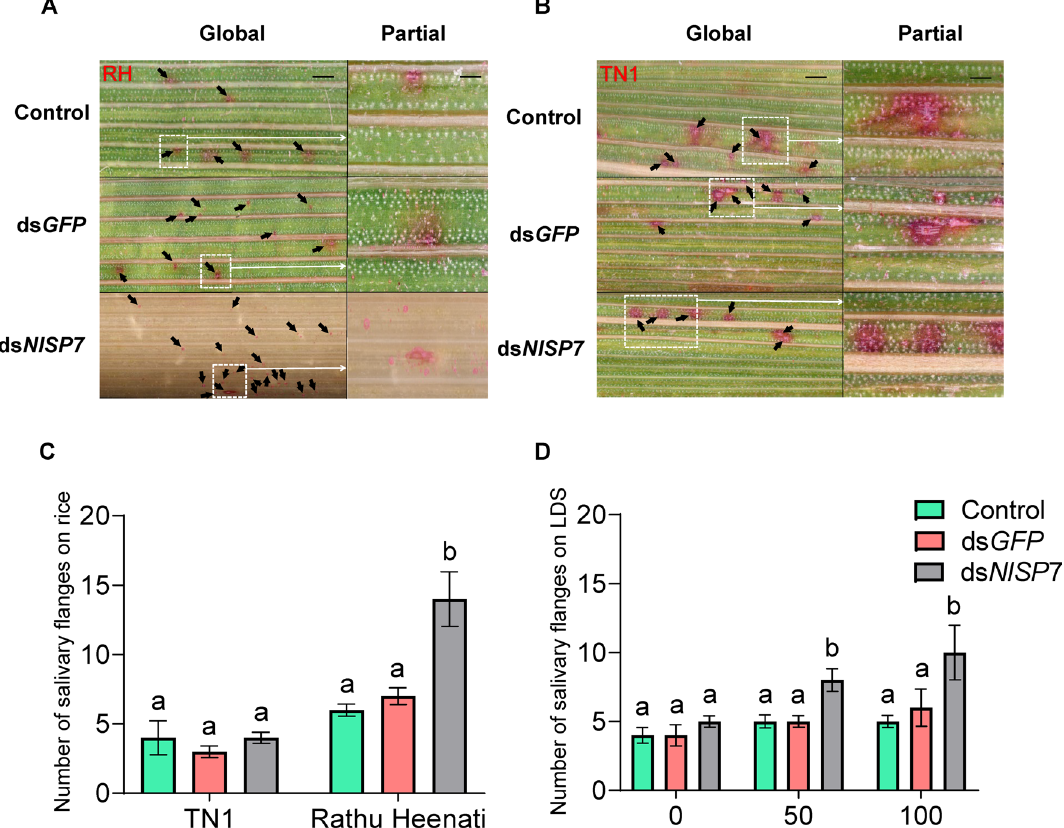
Figure 6. Number of salivary flanges created by brown planthoppers fed rice or an artificial diet, across different treatment groups (control, injected with ds GFP , injected with ds NlSP7 ). ( A , B ) images of salivary flanges produced on Rathu Heenati (RH) and Taichung Native 1 (TN1) rice varieties. The global of graphs, bars = 200 μm. The partial of graphs, bars = 50 μm. ( C ) Salivary flanges created by brown planthoppers fed different rice varieties. ( D ) Salivary flanges from brown planthoppers fed artificial diets with different levels of tricin. Bars with different letters are significantly different among different tricin levels. Data are represented as means ± SD, with 30 replications ( P < 0.01, Duncan’s multiple range